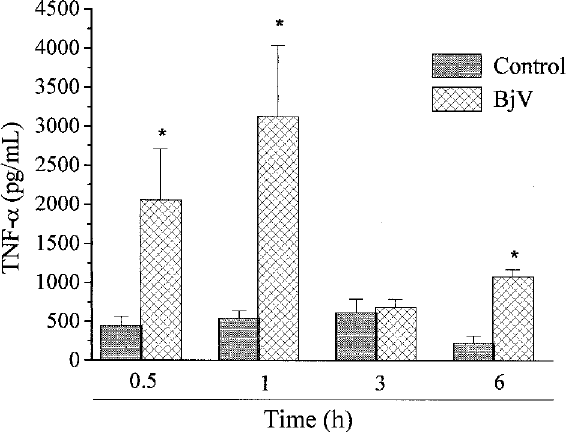
FIG. 4. Release of TNF- a induced by BjV in the peritoneal cavity of mice. Animals were injected i.p. with BjV (250 m g/kg) or sterile saline (control). Concentrations of TNF- a were assayed by cytotoxic activity on L929 cells. Each value represents the mean ± SEM from five to seven animals. * p < 0.05 compared with